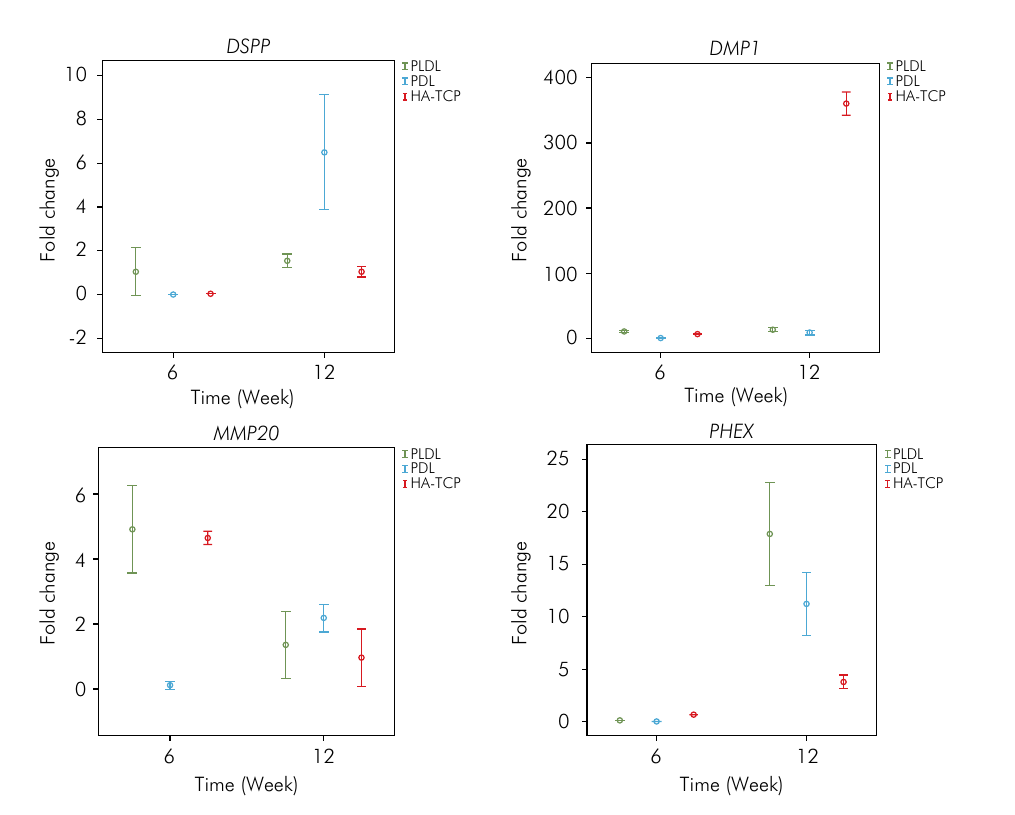
Figure. The fold change rates of DSPP, DMP1, MMP20 and PHEX in the experimental (+) groups compared to the control (-) groups for three scaffold materials, 6 and 12 weeks after